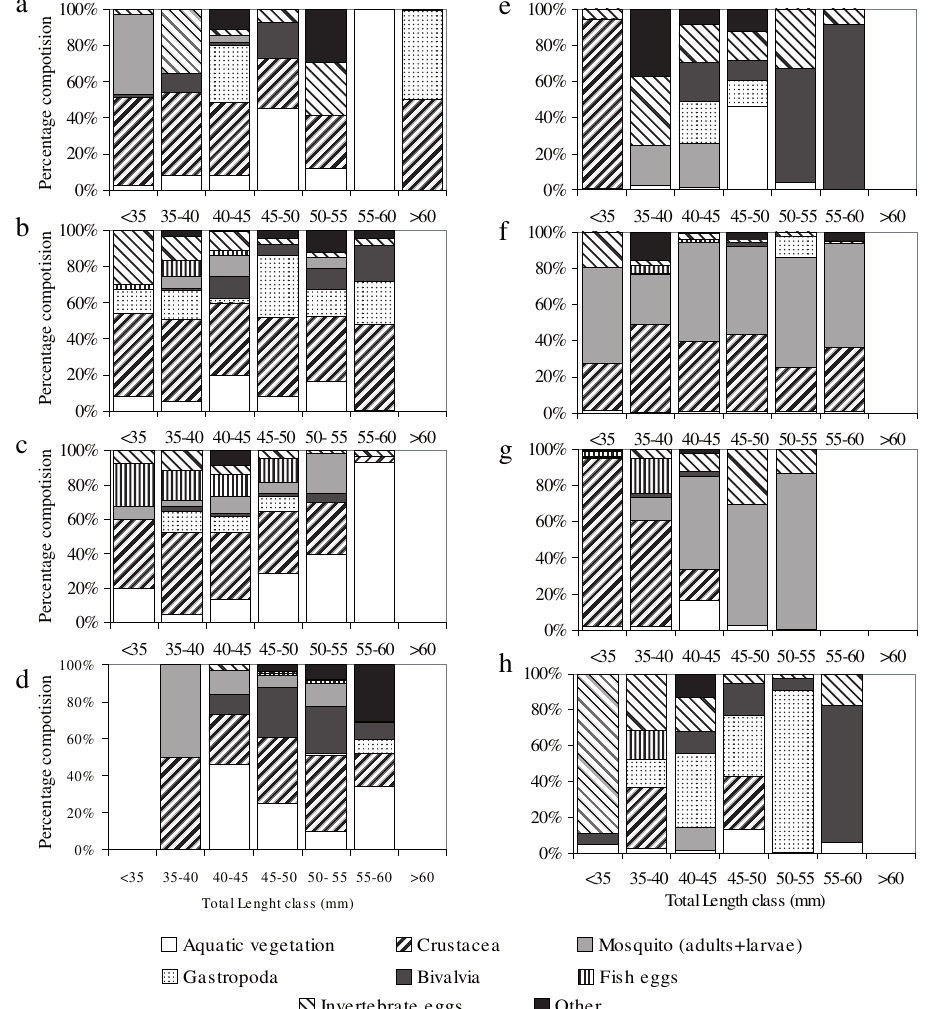
Fig . 3. – ontogenetic, seasonal and habitat variation in the diet of Aphanius fasciatus . data are the percentage of alimentary content volume averaged for 5 mm-length classes. (Messolongi Lagoon: a, winter; b, spring; c, summer; d, autumn. saltworks: e, winter; f, spring; g, summer; h,